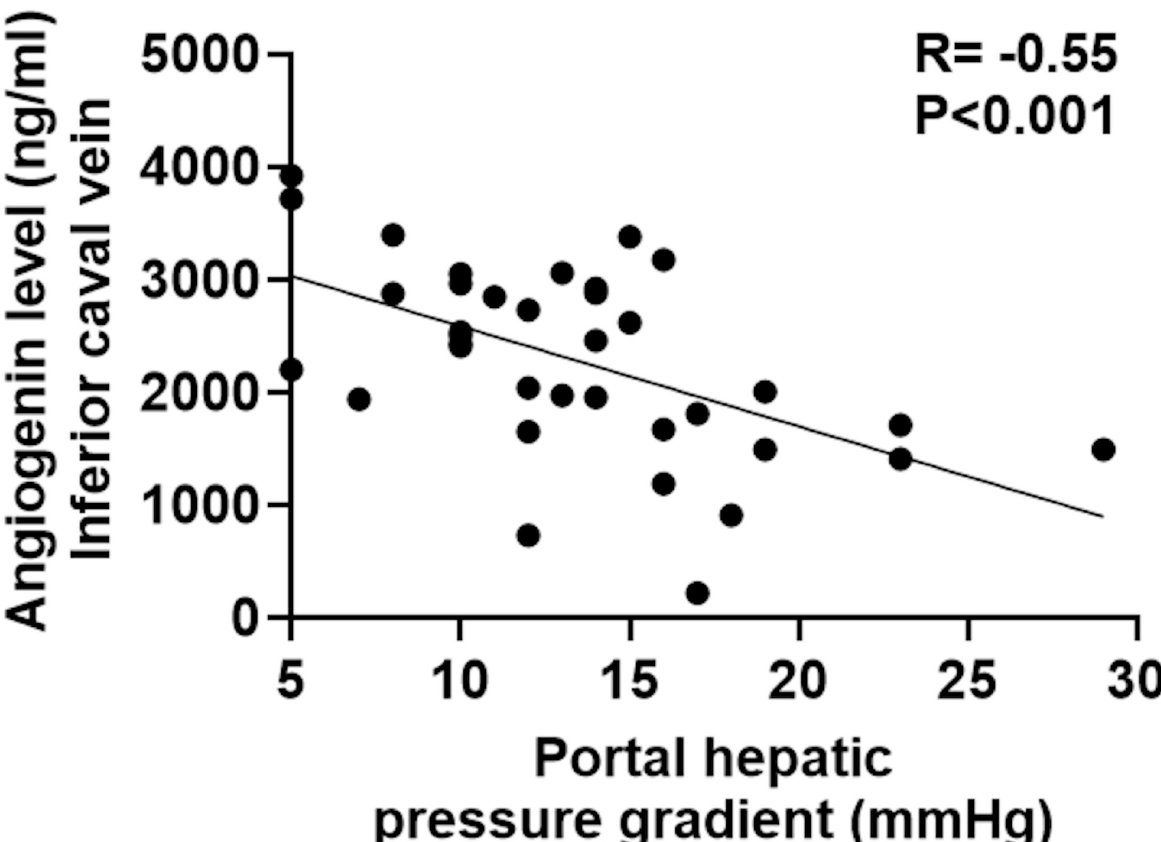
Fig 4. Correlation between angiogenin level in the inferior caval vein at follow-up angiography and portal hepatic pressure gradient. Pearson’s correlation test was used for analysis of correlations between portal hepatic pressure gradient and inferior caval vein angiogenin levels at follow up angiography. TIPS: Transjugular intrahepatic portosystemic shunt. n = 36.